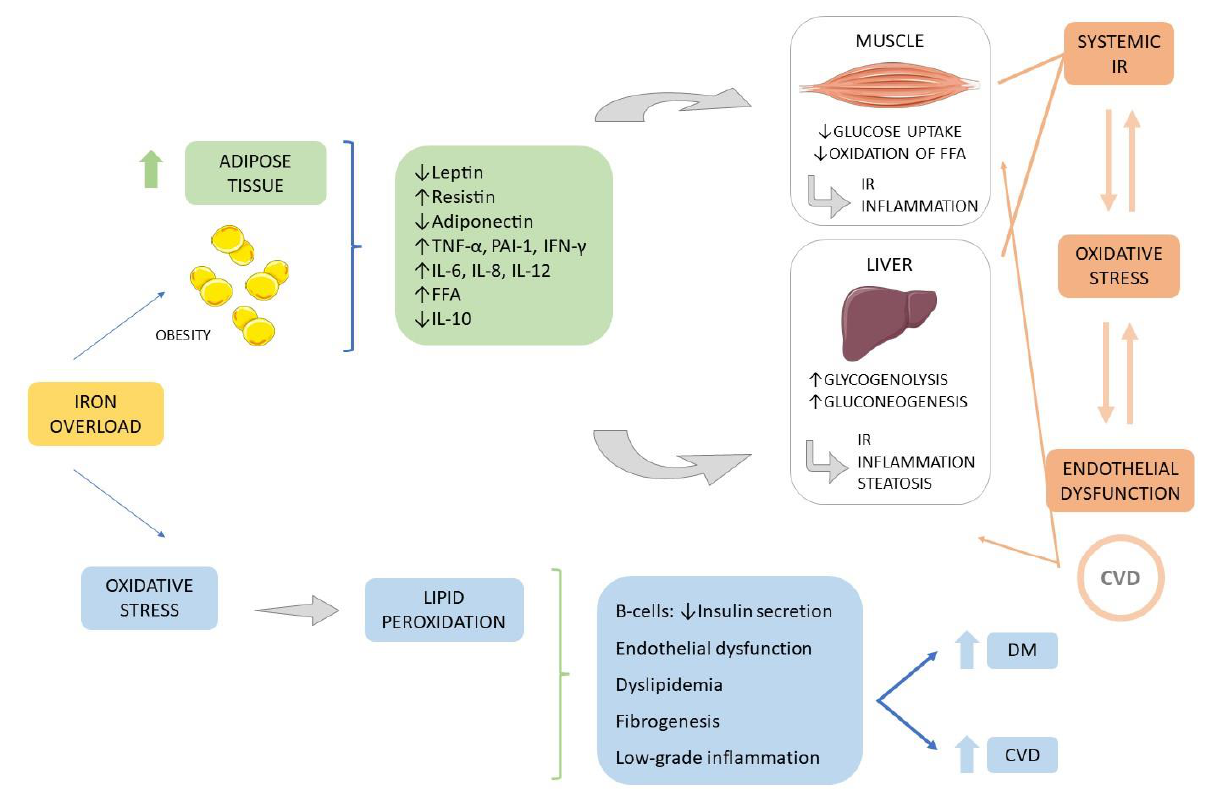
Figure 6. Obesity and oxidative stress in the pathogenesis of Diabetes mellitus and cardiovascular diseases. Increased abdominal adipose tissue is related to the release of pro-inflammatory cytokines (such as resistin, TNF- α , IFN- γ , IL-6, and IL-8), an increase of free fatty acids, reduction in adiponectin release and reduction of the anti-inflammatory IL-10). This scenario leads to an imbalance in the metabolism of glucose in the liver and muscles resulting in insulin resistance and the installation of an inflammatory scenario related to the development of DM and CVD. Associated with this scenario is also installed oxidative stress, which in turn is also associated with DM and CVD. CVD: cardiovascular disease; DM: diabetes mellitus; FFA: free fat acid; PAI-1: inhibitor of plasminogen activator; INF- γ : interferon- γ ; IL: interleukin; IR: insulin resistance; TNF α : tumor necrosis factor- α